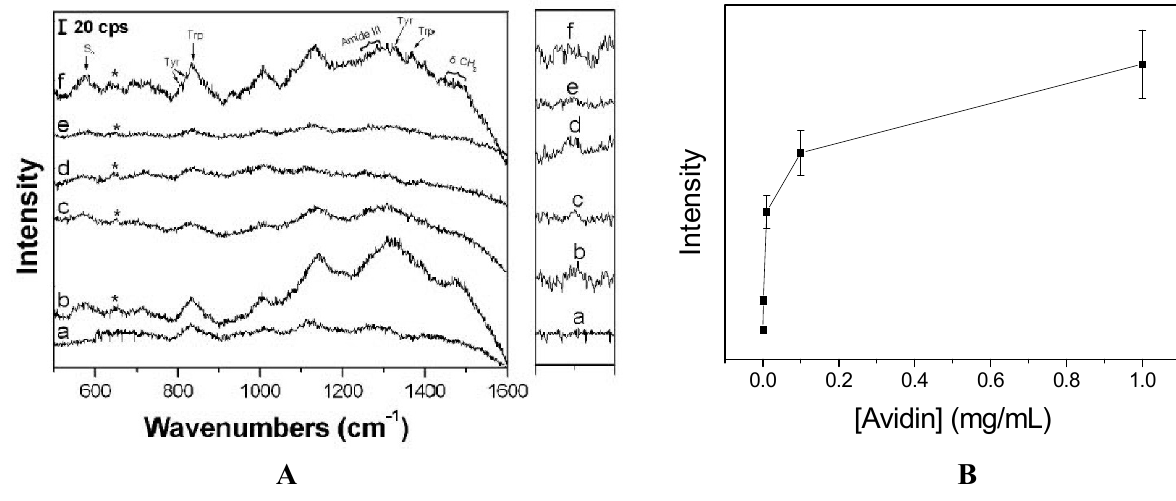
Figure 7. (A) SERS spectra of (a) the coupling complex between mercaptoethylamine-assembled gold nanoboots and biotins and its real-time detection of (b) 1mg/mL, (c) 0.1mg/mL, (d) 0.01mg/mL, and (e, f) 0.001mg/mL avidin. Except curve f (integration time: 50 s; scale bar: 8 cps), integration times of all SERS spectra were 20 s (scale bar: 20 cps). The right plot shows magnified spectrum peaks at 600- 700 cm -1 from the asterisks of the left plot. (B) Plot of SERS intensity respond to the concentration of